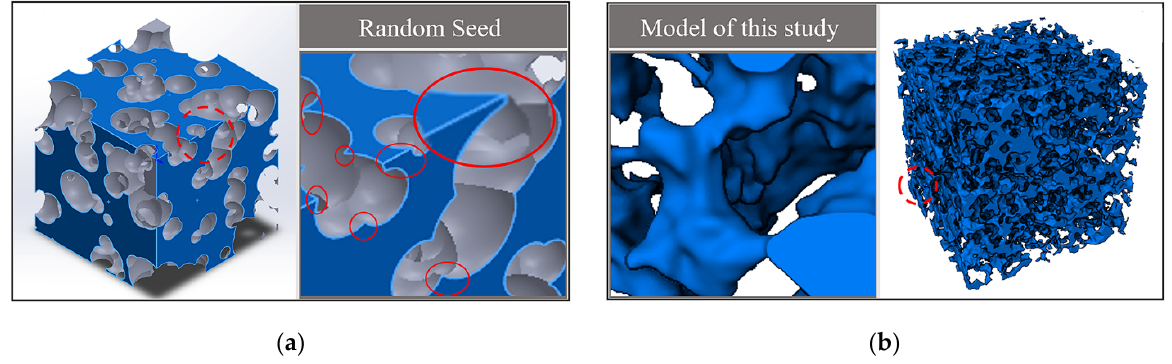
Figure 7. Comparison of modeling methods: ( a ) The random seed model; ( b ) Modeling model of this study.